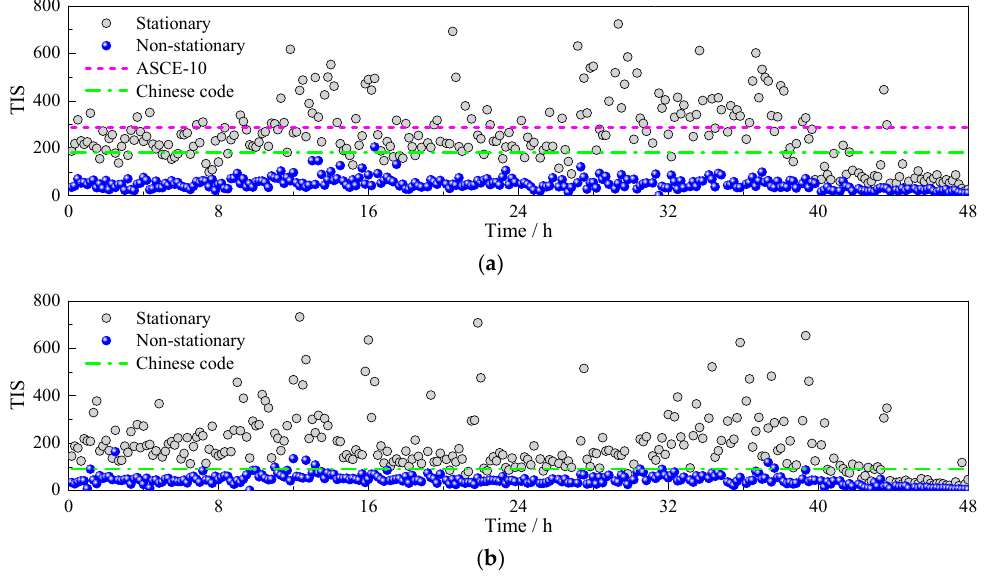
Figure 9. Turbulence integral scales based on stationary and non-stationary wind models: Turbulence integral scales based on stationary and non-stationary wind models: ( a ) longitudinal case; ( b ) lateral case. ( a ) longitudinal case; ( b ) lateral